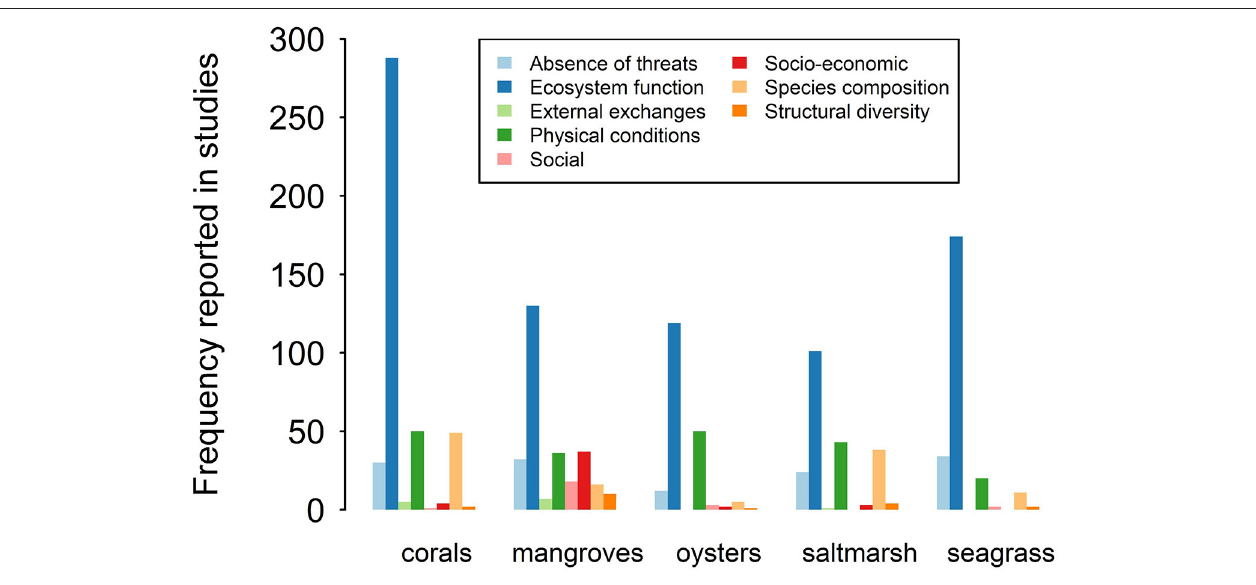
FIGURE 4 | Attribute categories of the variables measured to assess the restoration